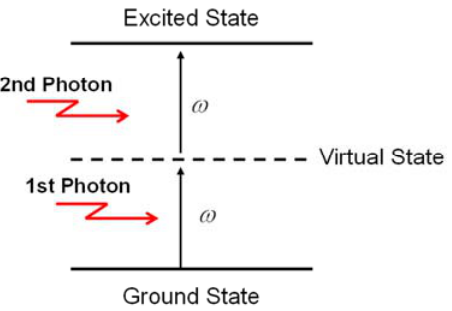
Figure 4. Two-photon absorption